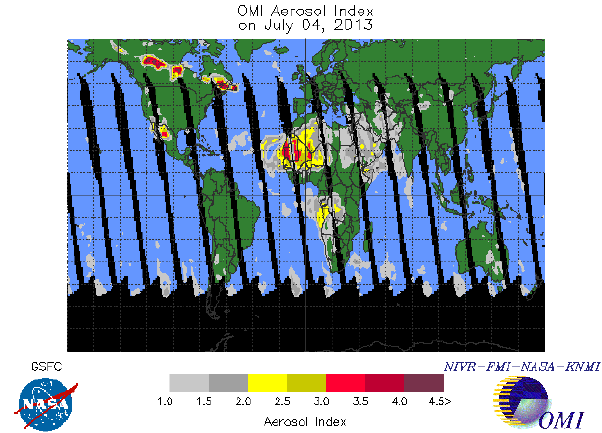
Figure 2. OMI aerosol index for 4 July